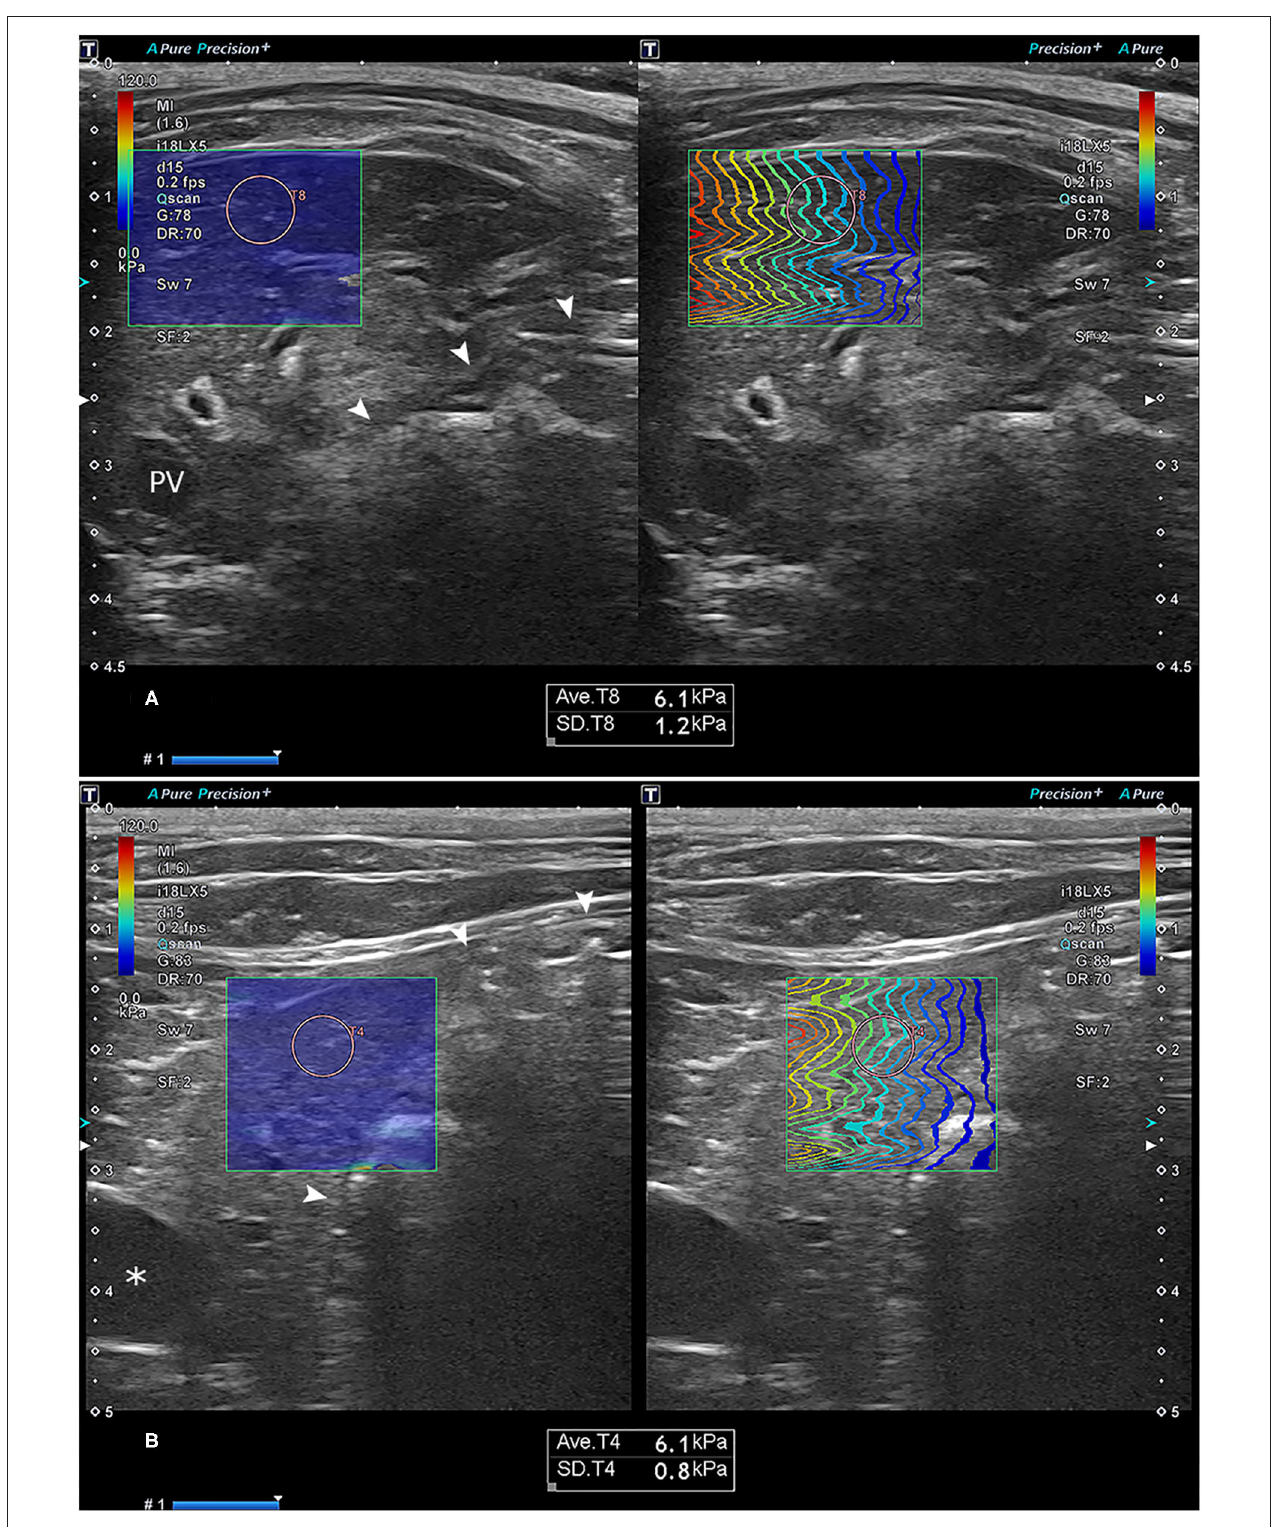
FIGURE 1 | Representative images of the two-dimensional shear-wave elastography measurement in the right (A) and left (B) liver. Note the optimal color-fill in the stiffness color mapping (left) and parallel wave propagation of the propagation map (right) in each site of the liver. The region-of-interest (ROI) circle, set to a 5-mm size, was placed in the liver parenchyma by avoiding the vessels and bile ducts. The text box below the ultrasonographic image shows the mean and standard deviation of the stiffness in the ROI. Asterisk: gallbladder; arrowhead: stomach. PV, portal vein.